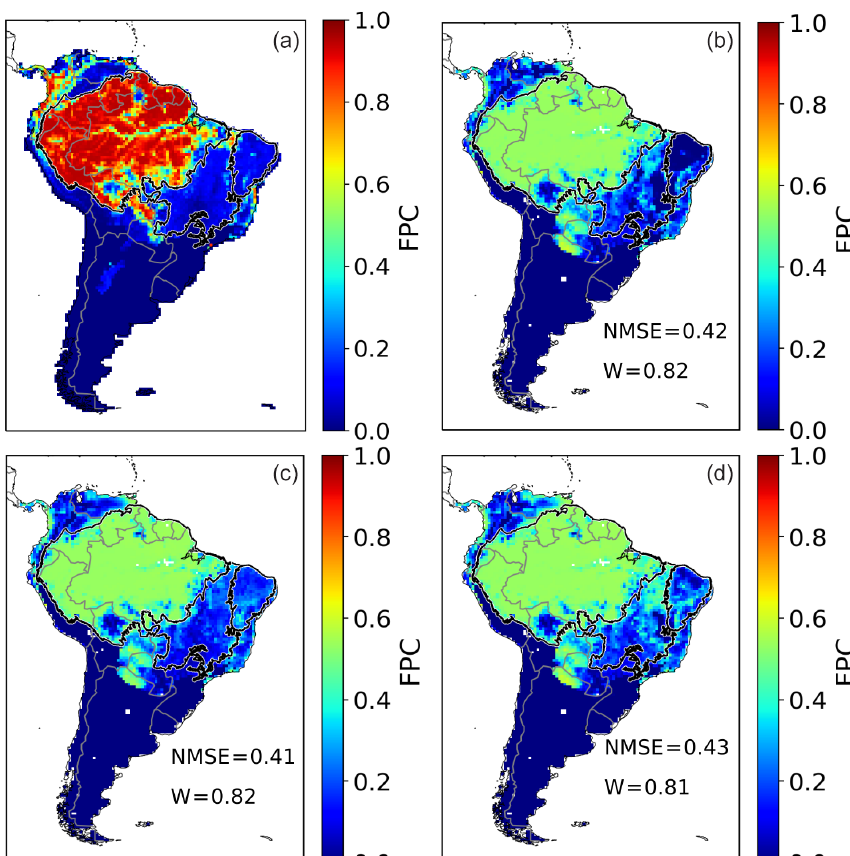
Figure 8. Annual FPC cover by tropical broadleaved evergreen PFT over a mean from 2005 to 2015 as fraction per cell. (a) ESA CCI evaluation data. (b) Simulated FPC by LPJmL4-SPITFIRE using the NI orig version. (c) Simulated FPC by LPJmL4-SPITFIRE using the VPD optim version. (d) Simulated FPC by LPJmL4-SPITFIRE using the NI optim